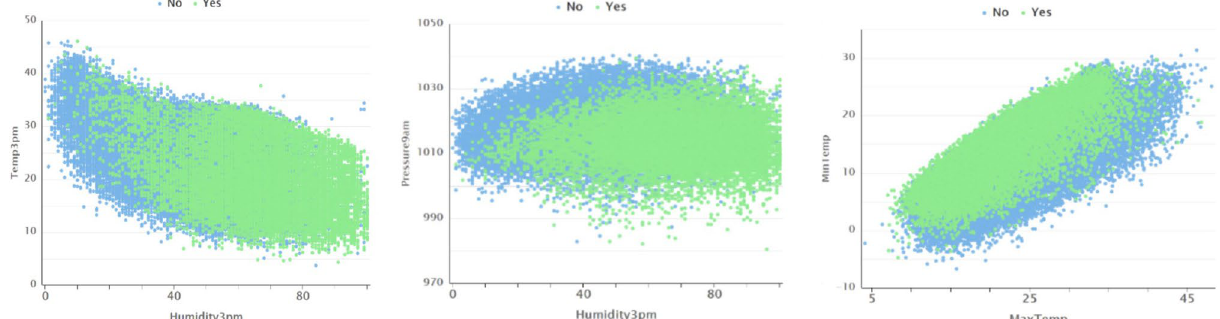
Figure 5. Box plots between significant